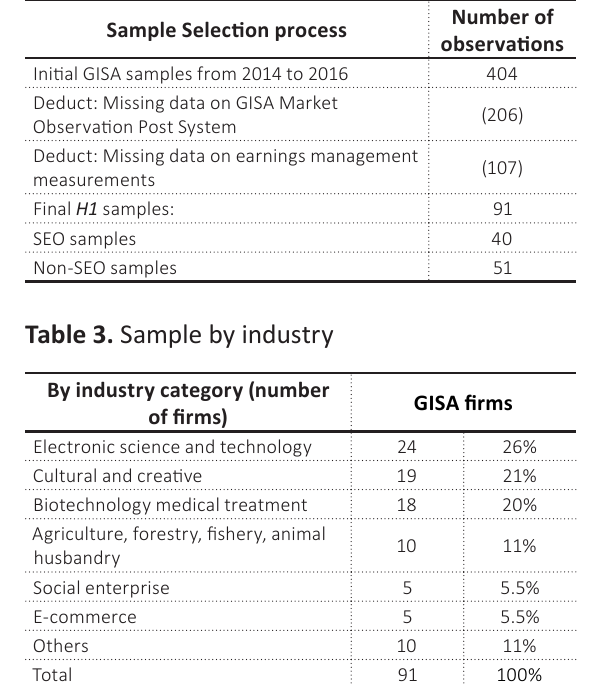
Table 2. Sample selection